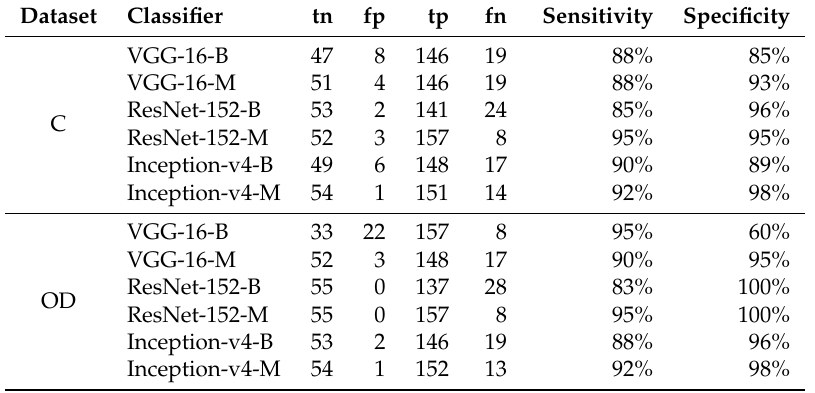
Table 6. Clinical evaluation of model performance for glaucoma diagnosis over the testing dataset.